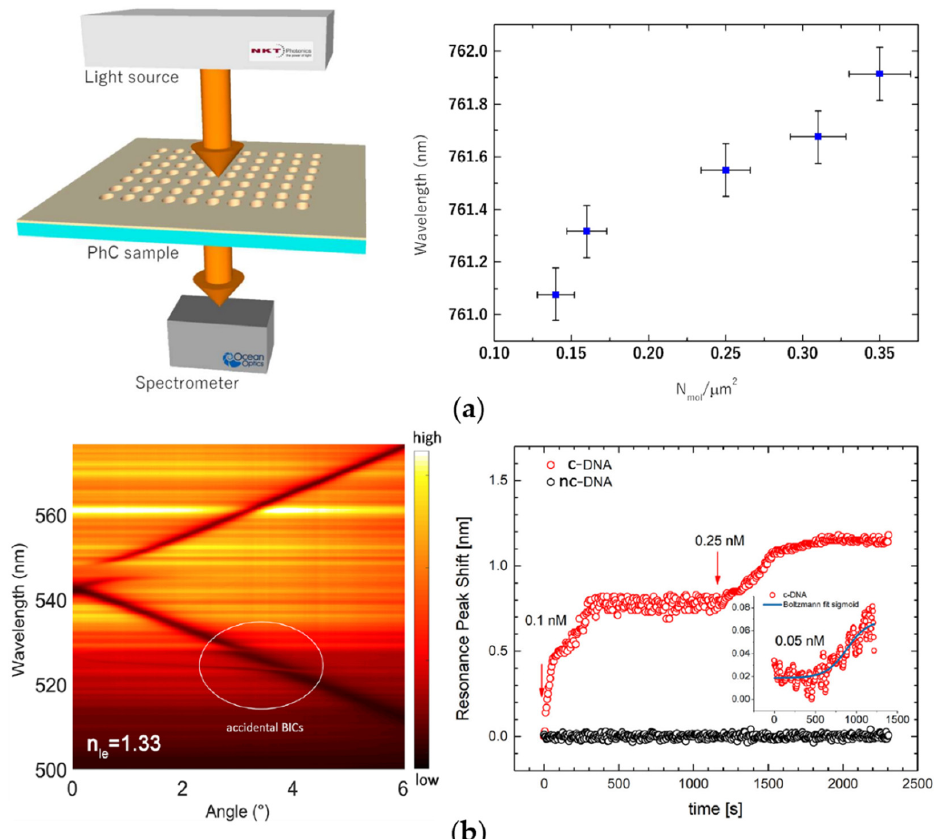
Figure 5. BIC biosensors composed of all-dielectric PhCSs. ( a ) A Si 3 N 4 PhCS utilized to recognize the interaction between tumor suppressor protein p53 and cancer protein MDM2 (reprinted with permission from [80], ©2018, Silvia Romano et al., CC BY license); ( b ) accidental BICs in PhCS for DNA detection (reprinted with permission from [83], ©2021, Gianluigi Zito et al., CC BY